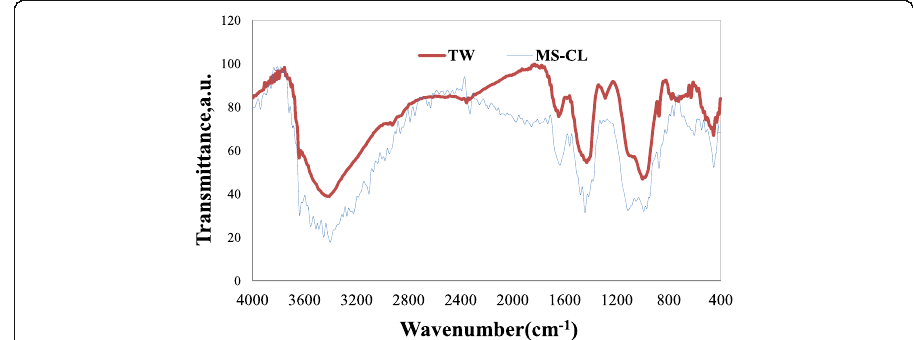
Fig. 13 I.R. spectra of OPCA100 samples under ACS with different aggressive media